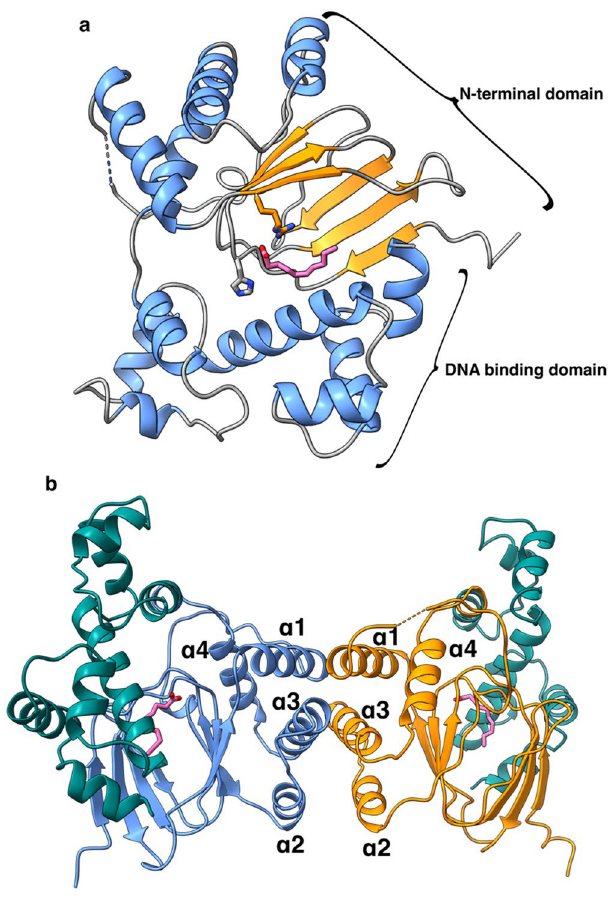
Figure 2. Structure of Rns and its potential dimerization interface. ( a ) Structure of SeMet-Rns showing decanoic acid modeled in the ligand binding pocket with α-helices in blue, β-sheets in orange, coils in gray, and the decanoic acid in pink. The N-terminal and DNA binding domains are labeled. ( b ) Proposed biological dimer with the N-terminal domains of the two monomers in orange or blue and both DNA binding domains in teal. The N-terminal α-helices are labeled. Images created with ChimeraX 38 .